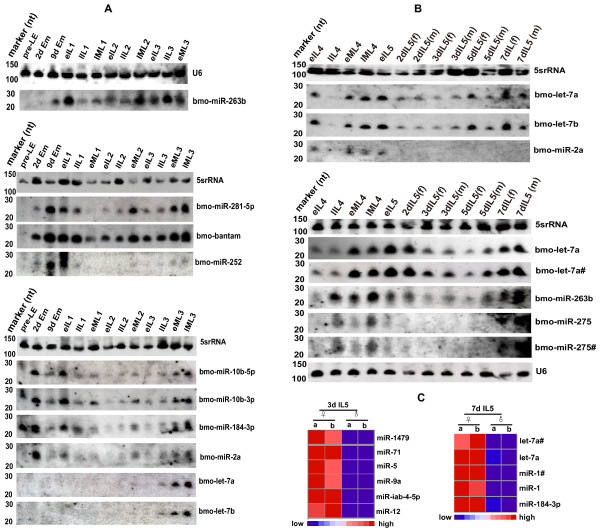
Northern blotting analysis of miRNA expression during the larval stages. (A) Northern blotting analysis of miRNAs during the early larval stages. (B) Northern blotting analysis of miRNAs during the late larval stages (C) A number of miRNAs displayed sex-dependent differences in expression at day 3 and day 7 fifth instar larval stages. 5srRNA and U6 served as the loading controls.